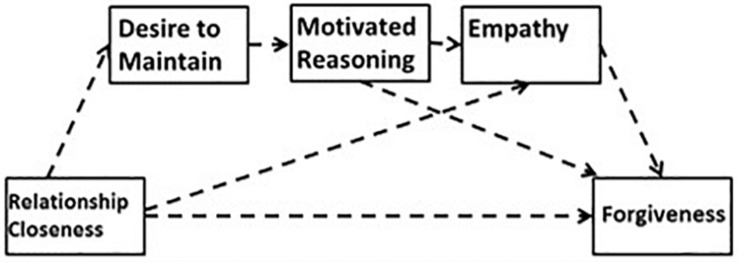
Analytic estimation used in Donovan and Priester (2017).